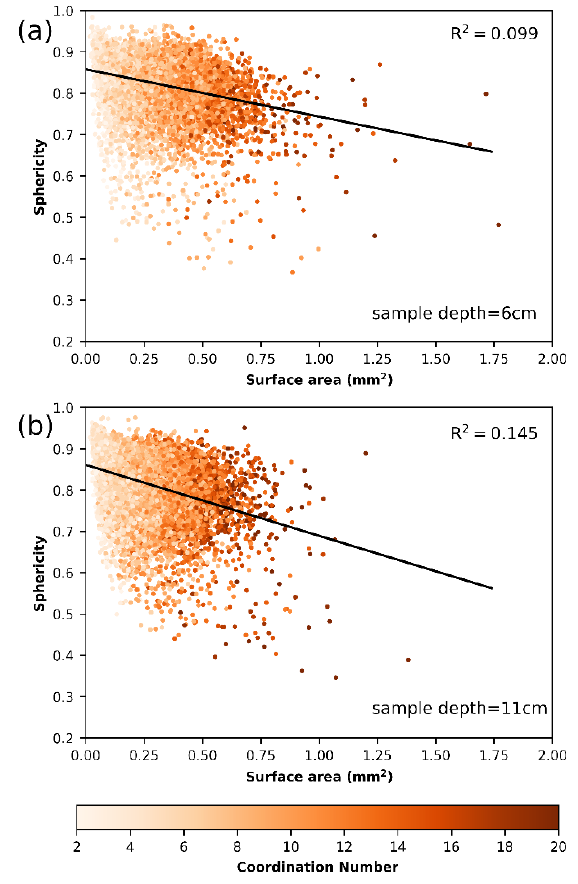
Figure 4. Relationship between coordination number, sphericity, and grain surface area for grains are analyzed in the (a) shallower and (b) deeper core. Covariance between sphericity and surface area is shown with a black line, assuming a linear